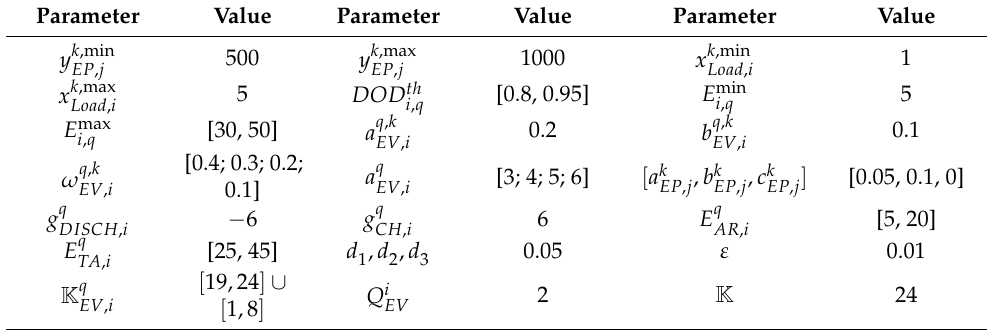
Table 2. Parameters